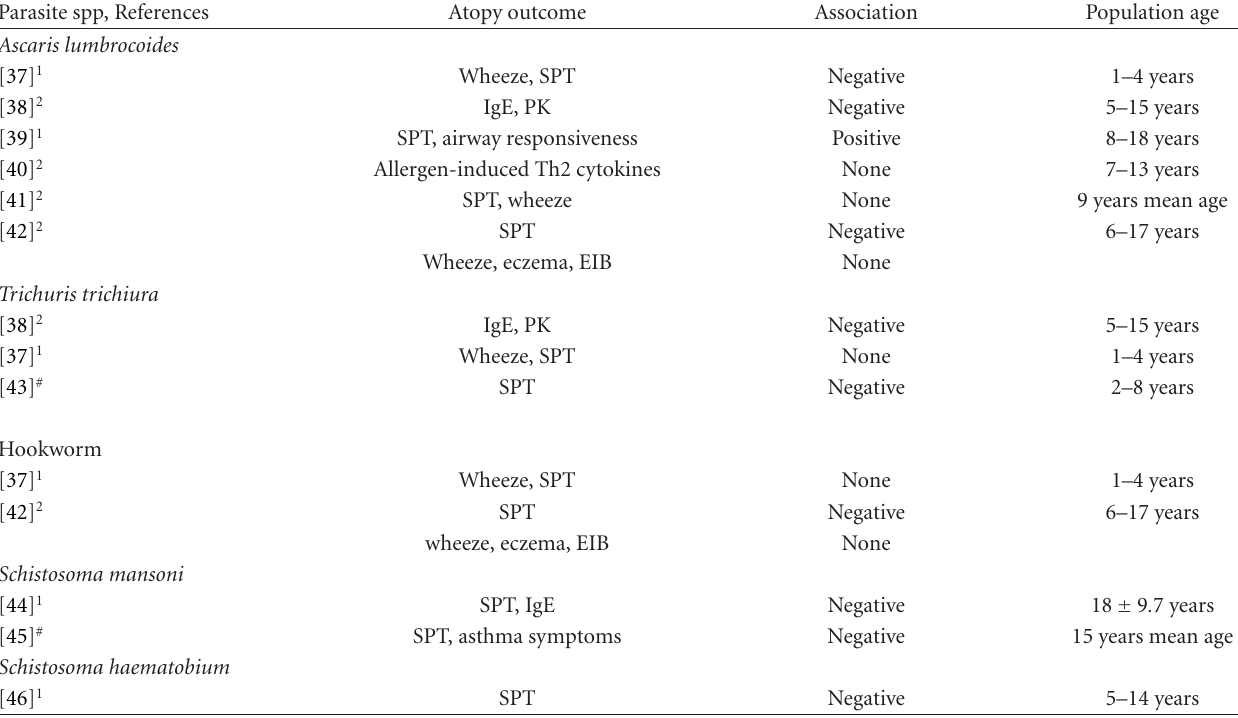
Table 1: Heterogeneity in studies investigating the e ff ect of helminth infection on